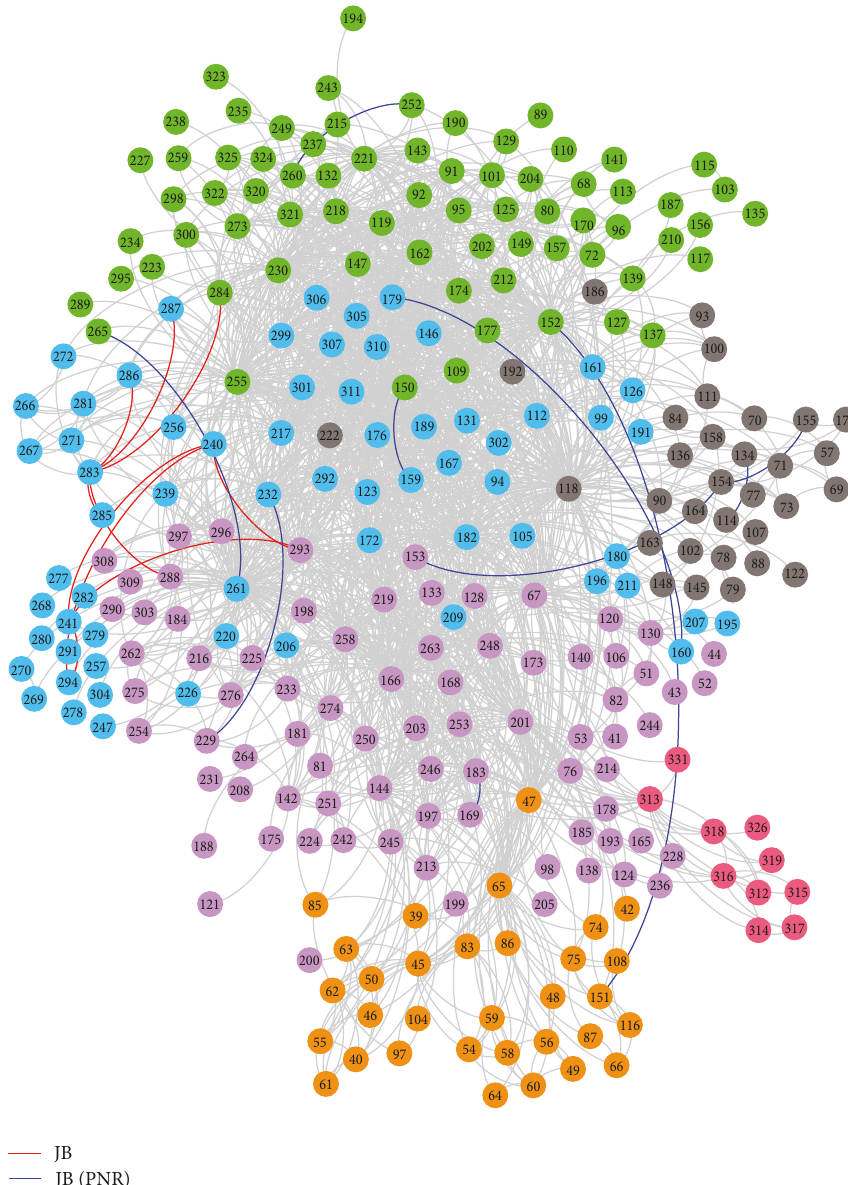
Figure 5: The comparison of the predicted edges between JB and the corresponding PNR methods in the Usair network. In the panel, we predict 10 edges for both JB and PNR methods. The Usair network is divided into different communities by the method in [37]. Nodes in JB the same community have the same color and short geographical distances. Our method (blue lines) predicts more edges between faraway nodes in different communities, while the original JB method (red lines) only predicts edges between close